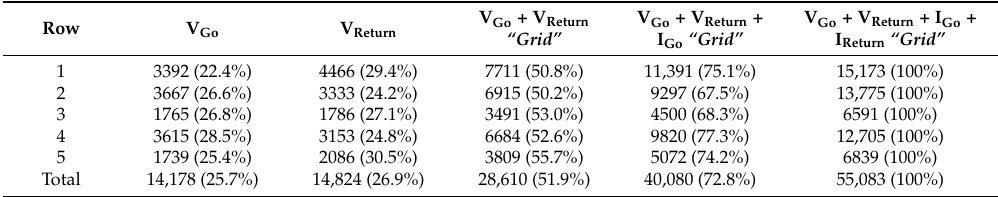
Table 6. Aerial point cloud provided during the data fusion (V:vertical LiDAR orientation; I:inclined LiDAR orientation). The percentage of the contributed points of each step during the fusion process is also presented.